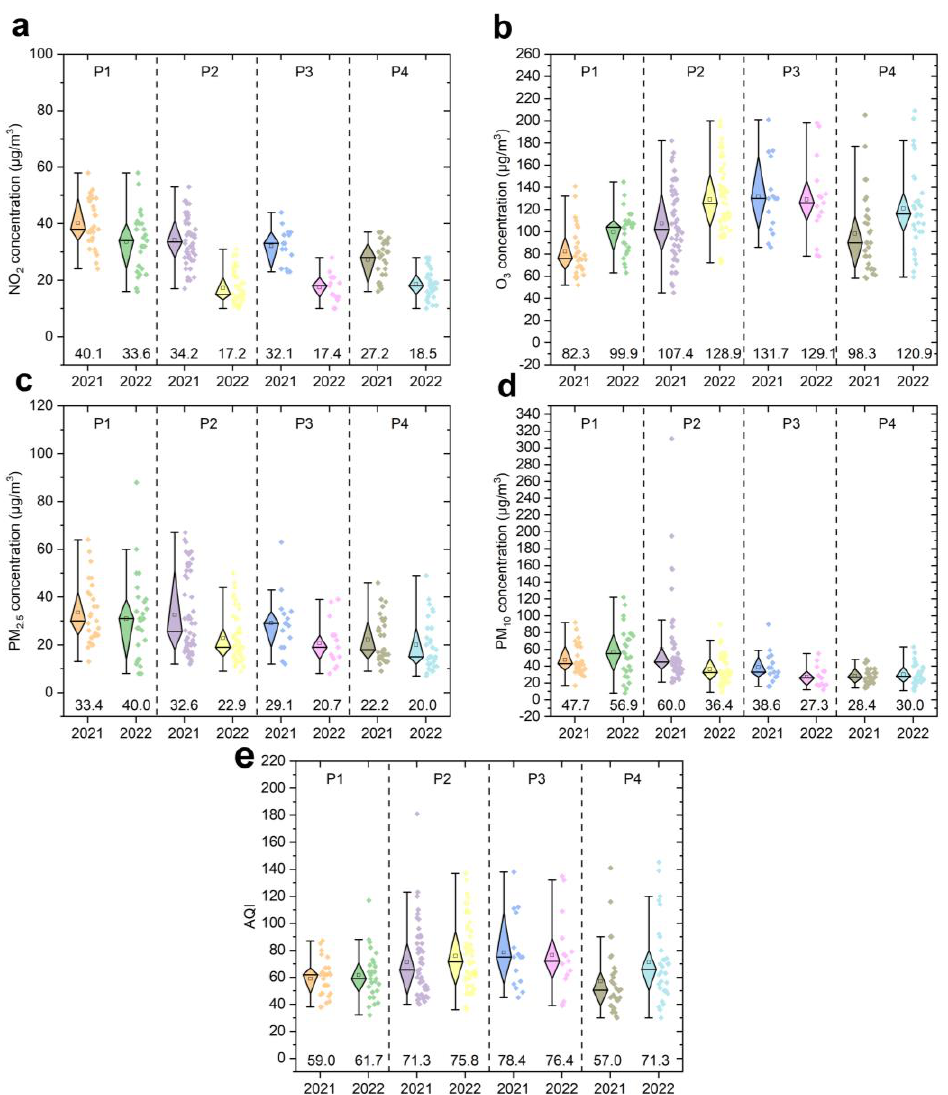
Figure 3. Daily air pollutant concentrations ( a - d ) and the AQI ( e ) during different periods (P1 – P4) in 2021 and 2022 over Shanghai. The average values during each period are presented at the bottom. The horizontal bar and rectangle inside each box present the median line and the mean value, re- spectively.